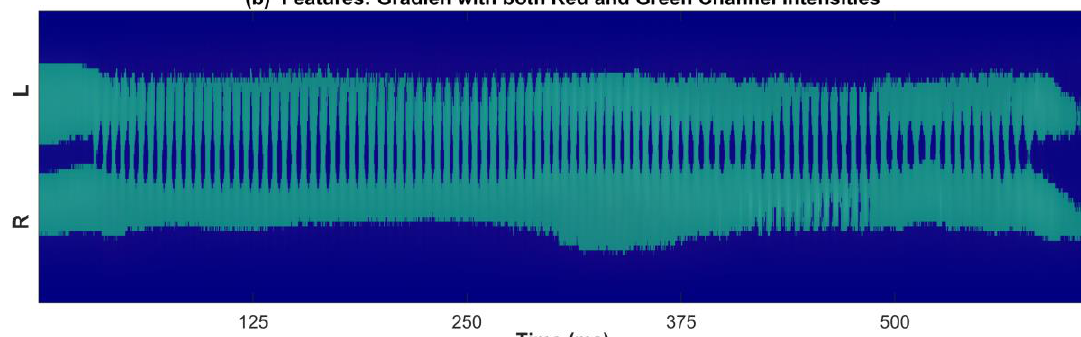
Appl. Sci. 2021 , 11 , x FOR PEER REVIEW 9 of 16